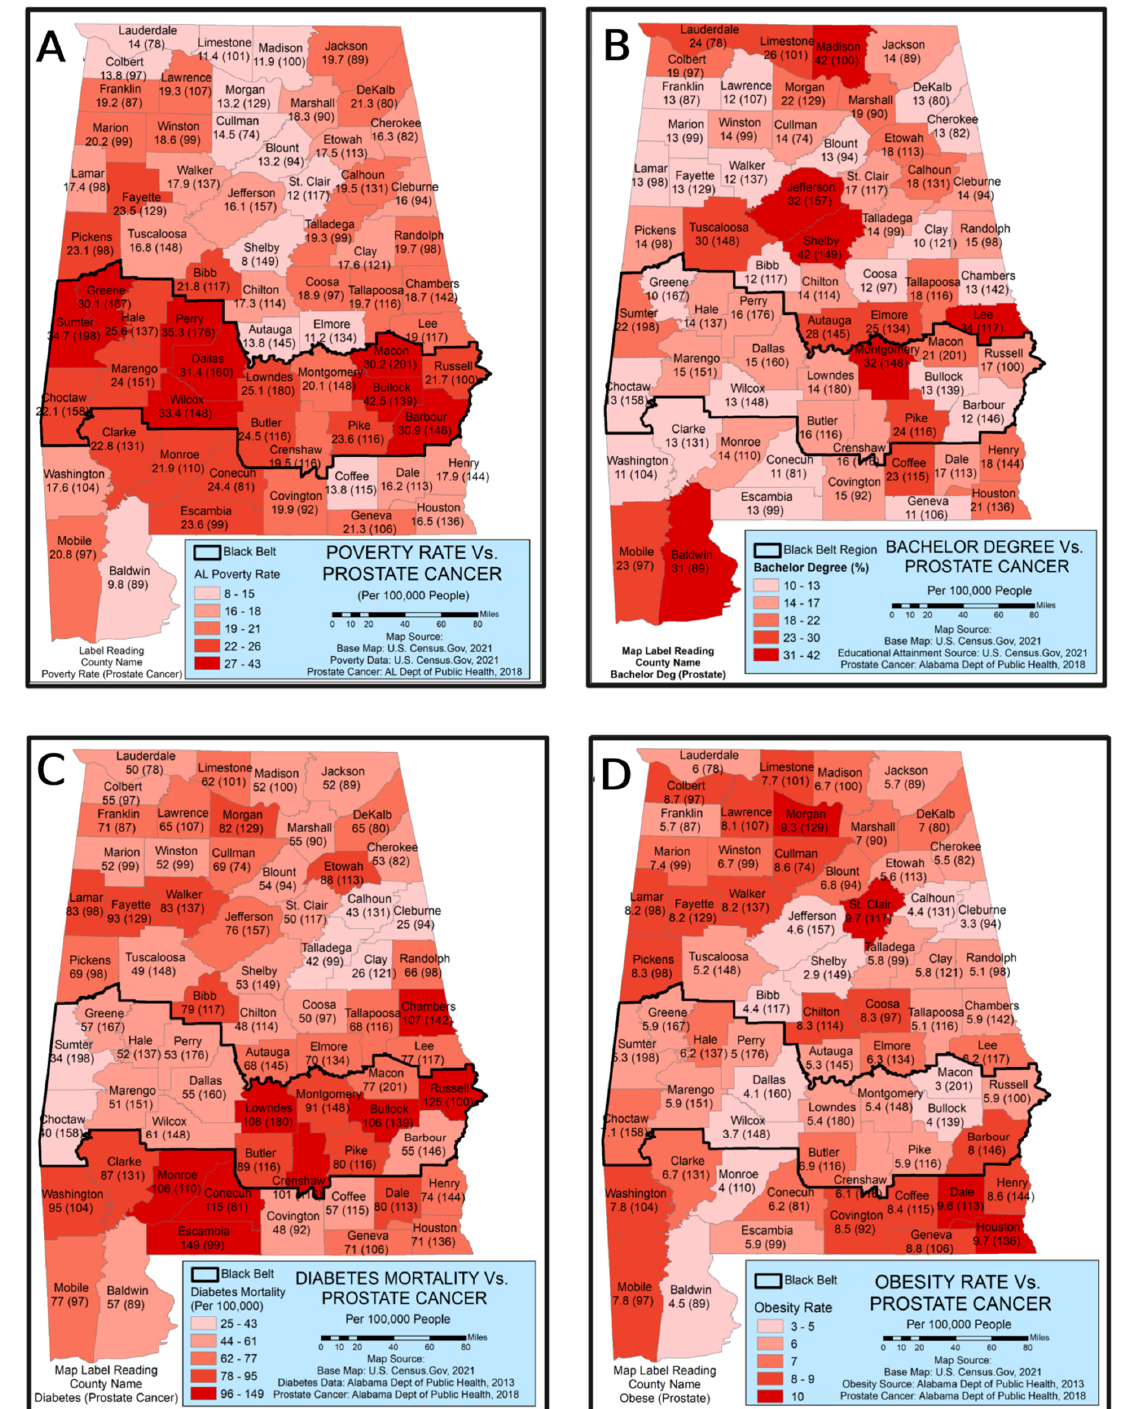
Figure 4. Four causal factors that impact the prostate cancer status in Alabama. This figure illustrates the county-level poverty distribution. ( A ) Bachelor’s degree attainment ( B ), diabetes epidemic ( C ), and obesity status ( D ) in Alabama. These four factors are highly prominent in the black belt region. The poverty rate spread out across the state; the Black Belt counties (dark shaded region) face the highest poverty status compared to non-Black Belt counties. Similarly, there is a significant reduction in education in Black Belt counties with increased diabetes and obesity. Data source: Base Map;